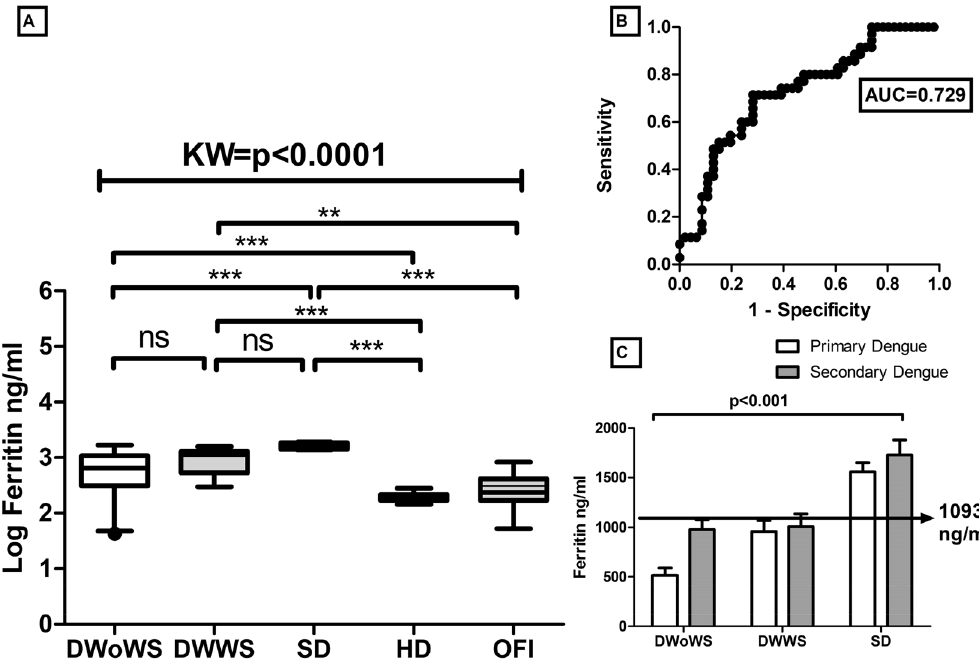
Figure 4. ( A ) Levels of Ferritin protein of dengue without warning sign (DWoWS), dengue with warning signs (DWWS), severe dengue (SD) and Other febrile infection (OFI). Study subjects are significantly different from each category. ( B ) Receiver operating characteristics curve analysis obtained the AUC = 0.729. ( C ) Levels of Ferritin of primary and secondary dengue infection. Arrow line showing the severity cut ‐ off value (1093 ng/mL) obtained from the Youden index. Study subjects are significantly different from each category is indicated by P < 0.05. AUC, area under the curve; HD, healthy donors.Statistical analysis was performed using the